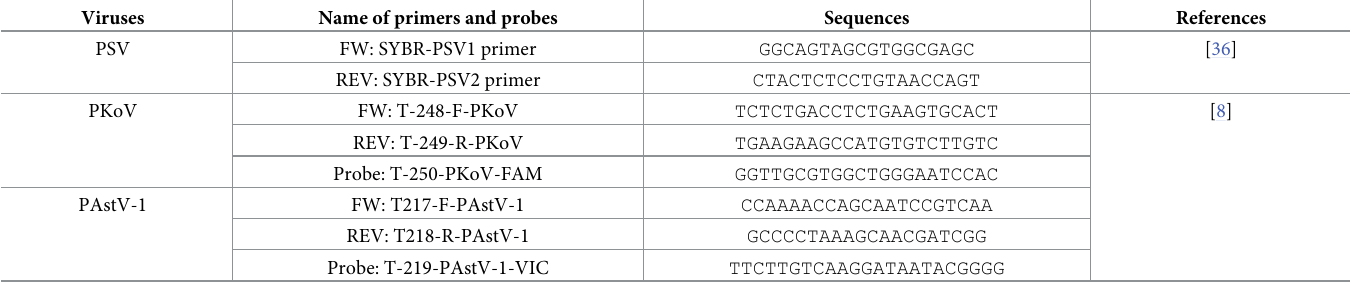
Table 1. RT–qPCR detection assays used in the